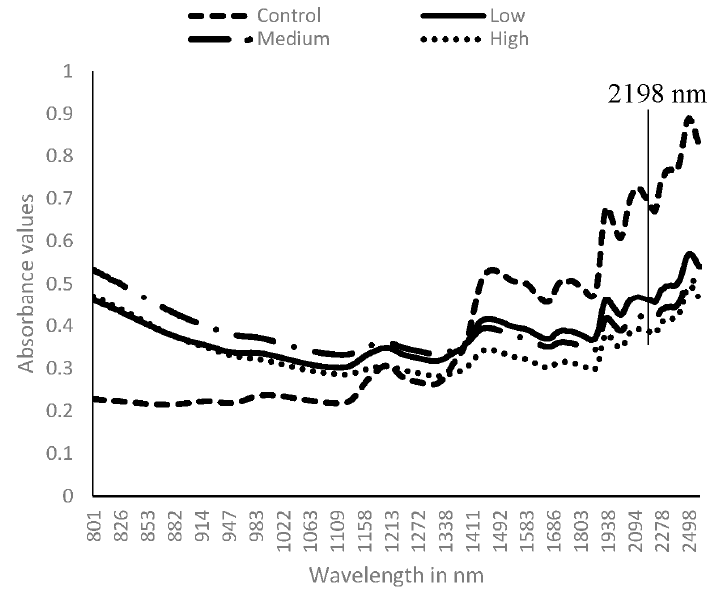
Figure 4. NIR spectral pattern of inoculated maize kernels from 800–2600 nm.